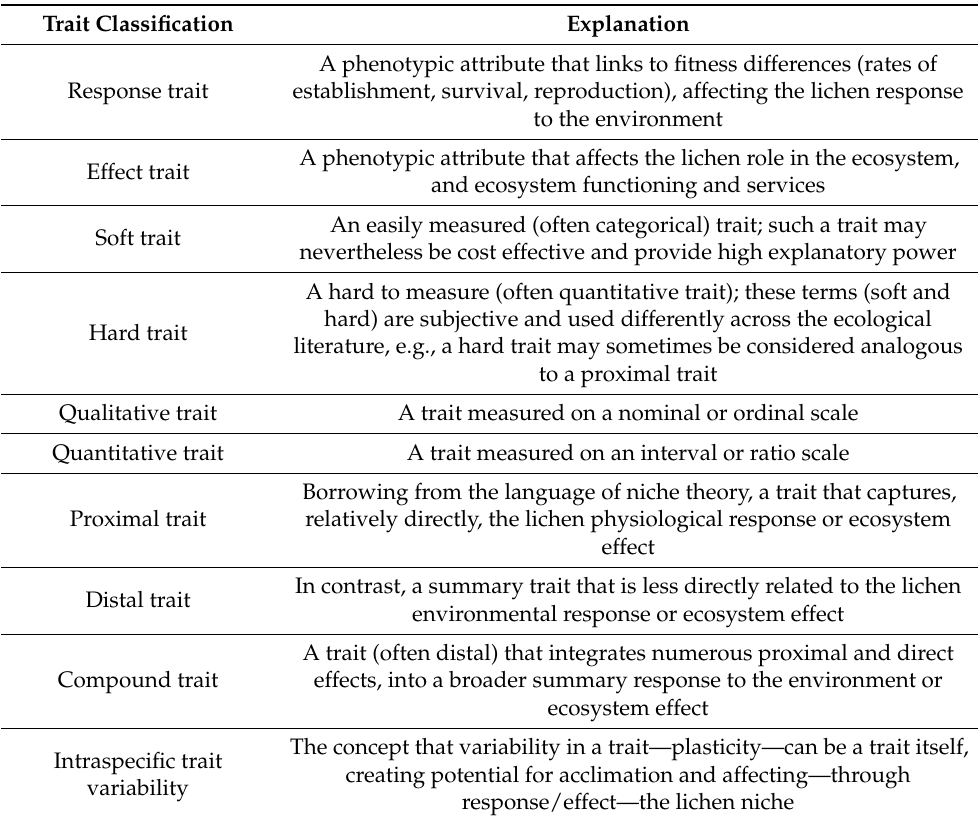
Table 1. A glossary of terminology used to classify trait-based